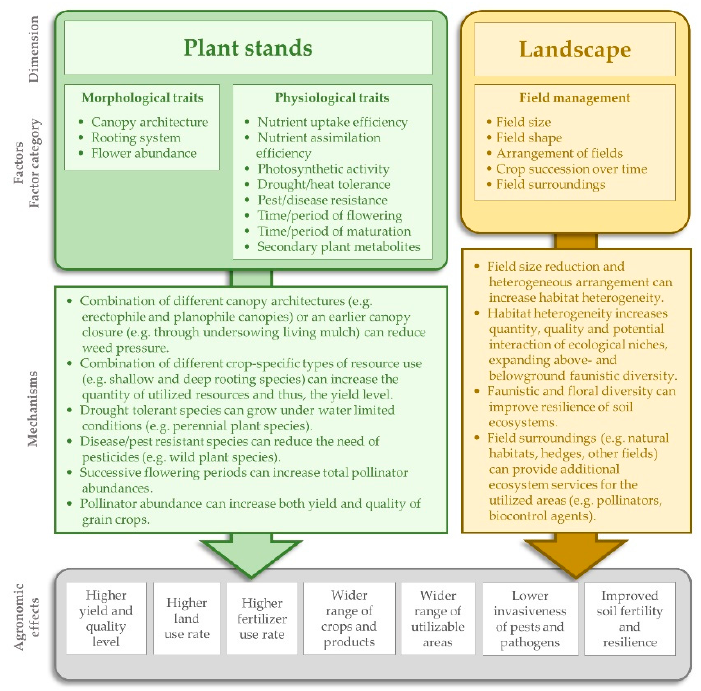
Figure 3. Factors and mechanisms potentially determining agronomic e ff ects of agricultural diversification of bioenergy cropping systems both between (brown boxes) and within the plant stands (green boxes) (adapted from [109]). Note, that the agronomic e ff ects (grey box) show the potential outcome for a best-case